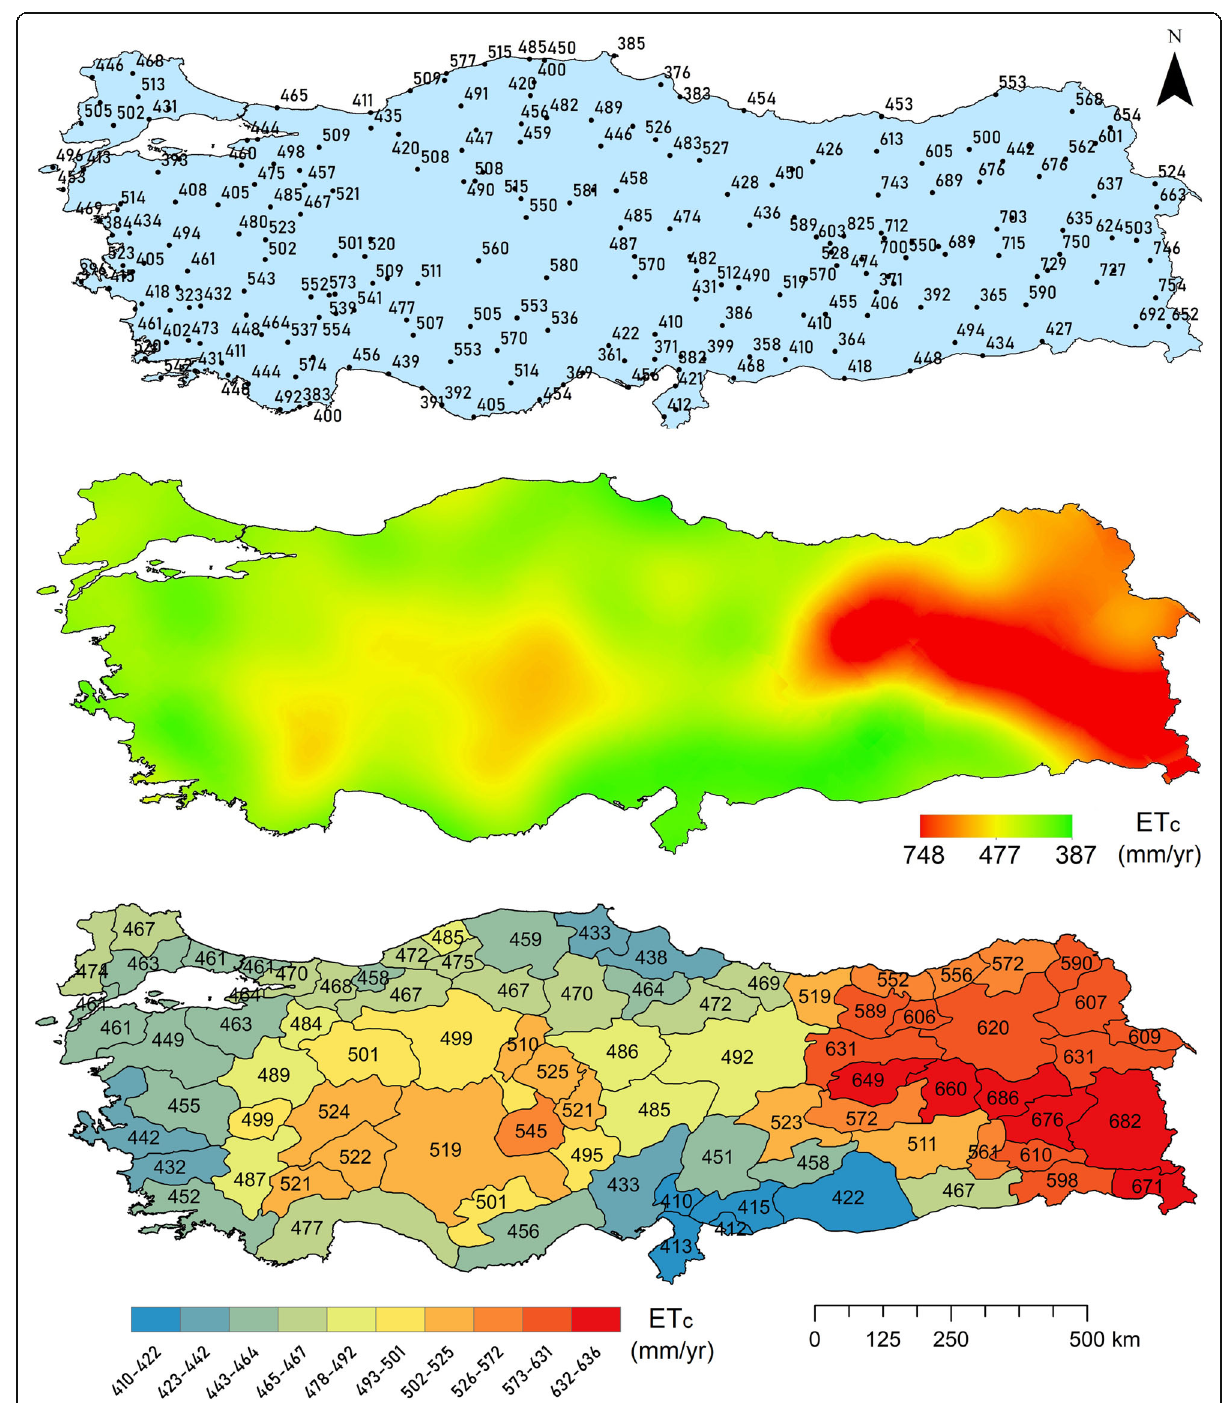
Fig. 2 Obtaining annual ET c distribution of wheat within Turkey (from top to bottom; station observations (TAGEM 2017), spatial interpolation and getting the zonal statistics of annual average for each